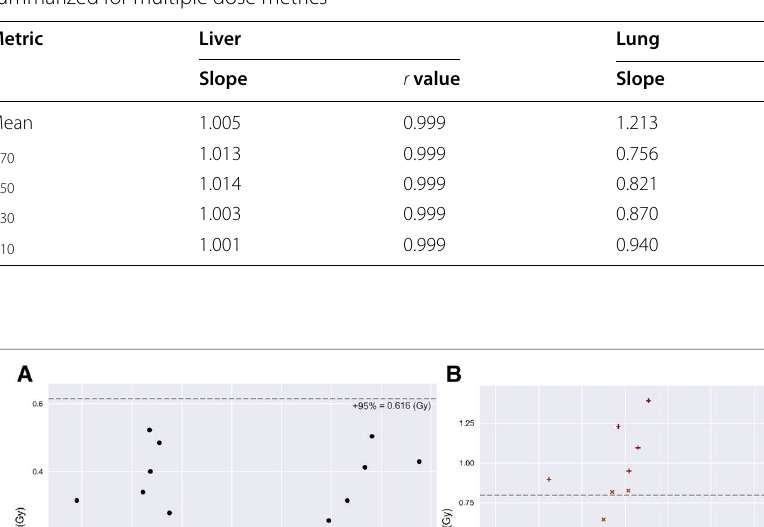
Fig. 5 The Bland Altman analysis plots the mean bias and 95% CIs between the CT and nominal local deposition methods for the mean doses ( A , C ) and all the cumulative dose volume histogram (DVH) dose metrics ( B , D ). Parts A , B refer to the liver while C , D refer to the lungs. Parts A , C compare between every self-calibration mean dose estimate for the liver N = 25 and the lungs, N = 20 . Parts B , D compare between every self-calibration DVH dose metric in the liver N = 100 and the lungs N = 80 . N represents the number of data points compared for each Bland Altman plot. The lungs did not include the Liver